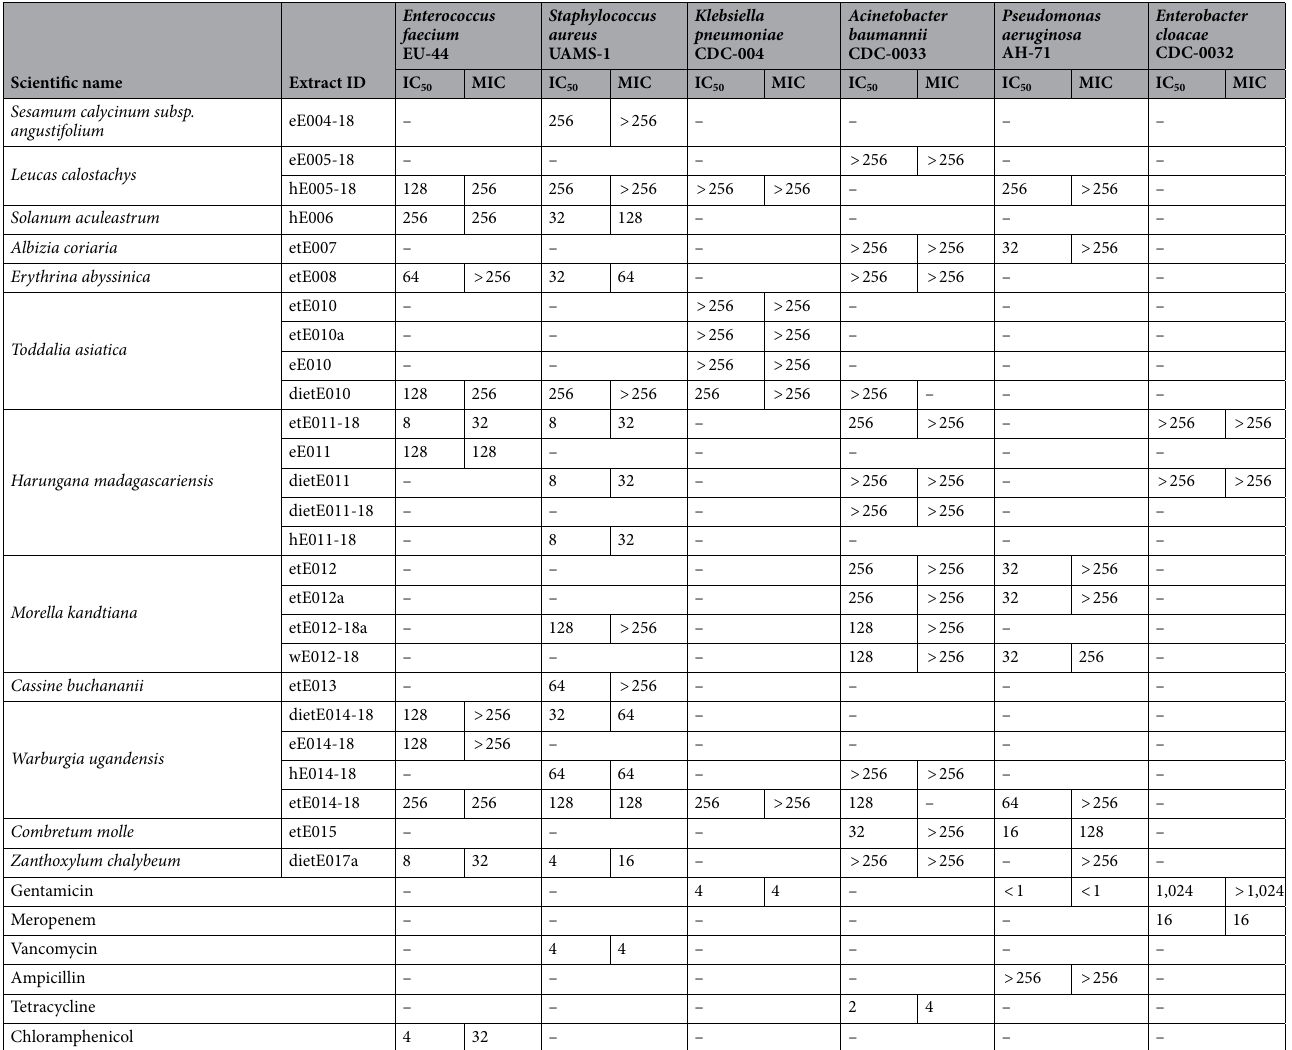
Table 1. Results of growth inhibition of selected ESKAPE pathogens by medicinal plant samples from the Greater Mpigi region in Uganda. Only extracts that showed growth inhibition above 40% in the initial screen are listed. Crude extracts obtained during maceration were labeled according to their extraction solvent: (a) methanol (mEXXX); (b) ethanol (etEXXX); (c) ethyl acetate (eEXXX); (d) diethyl ether (dietEXXX), where ‘XXX’ stands for the sample number assigned to a given plant species. Crude extracts produced via Soxhlet extraction were labeled: (e) n-hexane (hEXXX); (f) methanol, successive extraction (smEXXX). In most cases, we recorded that the traditional healers prepare herbal drugs by boiling the plant material in water. Therefore, the original method of preparation was simulated by an aqueous decoction (wEXXX). Results are reported as the minimum concentration of extract that achieved 50% inhibition (IC50) and 90% inhibition (MIC) of growth as detected by optical density measures. IC 50 and MIC values are expressed as concentration (μg/mL). The maximum concentration at which extracts were tested was 256 μg/mL. Dashes indicate that a sample was not